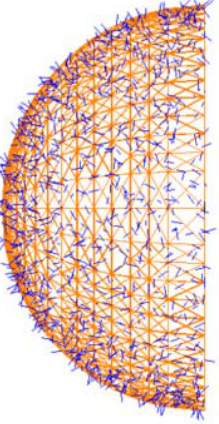
Figure 3. Light source for diffuse light analysis.